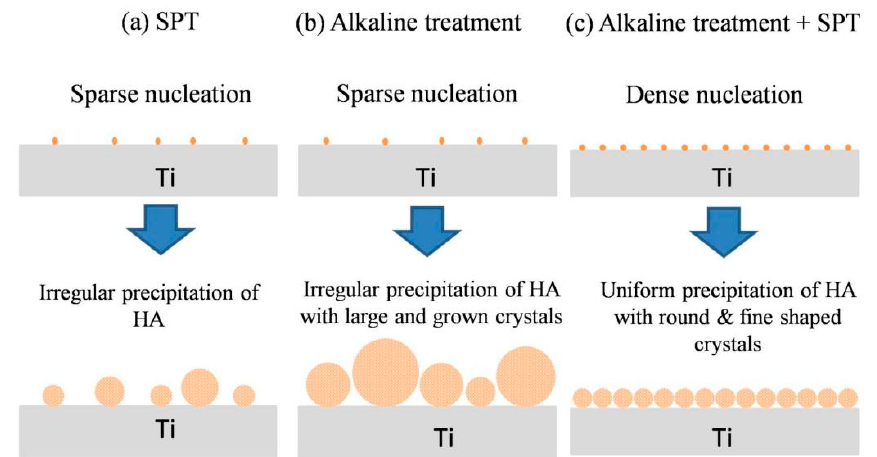
Figure 12. Schematic illustration of HA nucleation and HA crystal growth on the titanium surfaces. The appearance of particles formed on the Ti surface was quite different among ( a ) Ti-SPT, ( b ) Ti-AT-IT, and ( c ) Ti ‐ AT ‐ SPT.